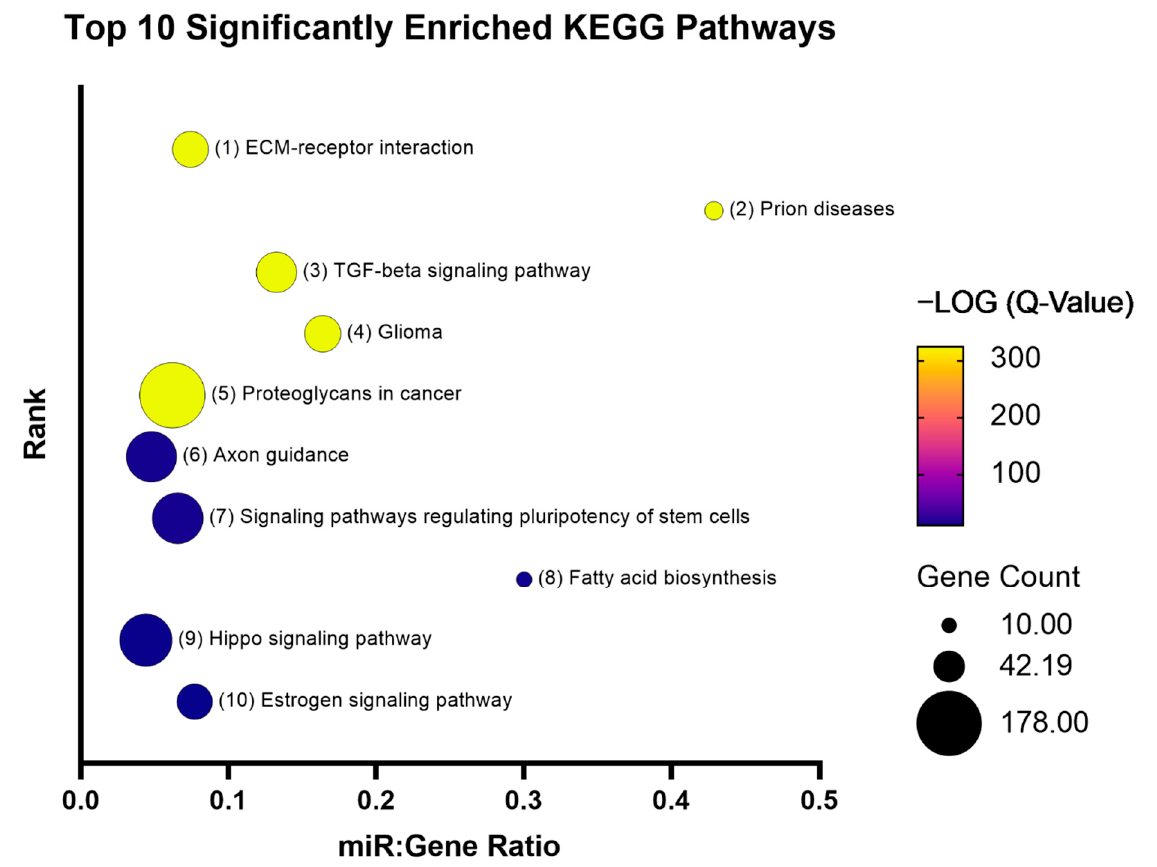
Figure 4. Bubble plot represents the top 10 significantly enriched KEGG pathways for the 23 dysregulated miRNAs. The coloured scale bar indicates the − LOG (Q-value) where yellow indicates more significance and blue indicates less significance. Q-value is the FDR adjusted p -value. Bubble size represents the number of genes targeted in that particular pathway (gene count). The y -axis represents the pathway rank from most to least significant (1 through 10). The x -axis represents the number of miRNAs that are enriched in a particular pathway relative to the number of target genes that are enriched in the same pathway, known as the miR:gene ratio. Table 2. Dysregulated miRNAs identified by the microarray analysis. Table includes the miRNA accession code (miRBase Identification Code), microarray assay target sequence, and fold change.